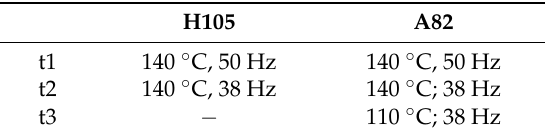
Table 2. Set-point temperature and pump operating frequency.